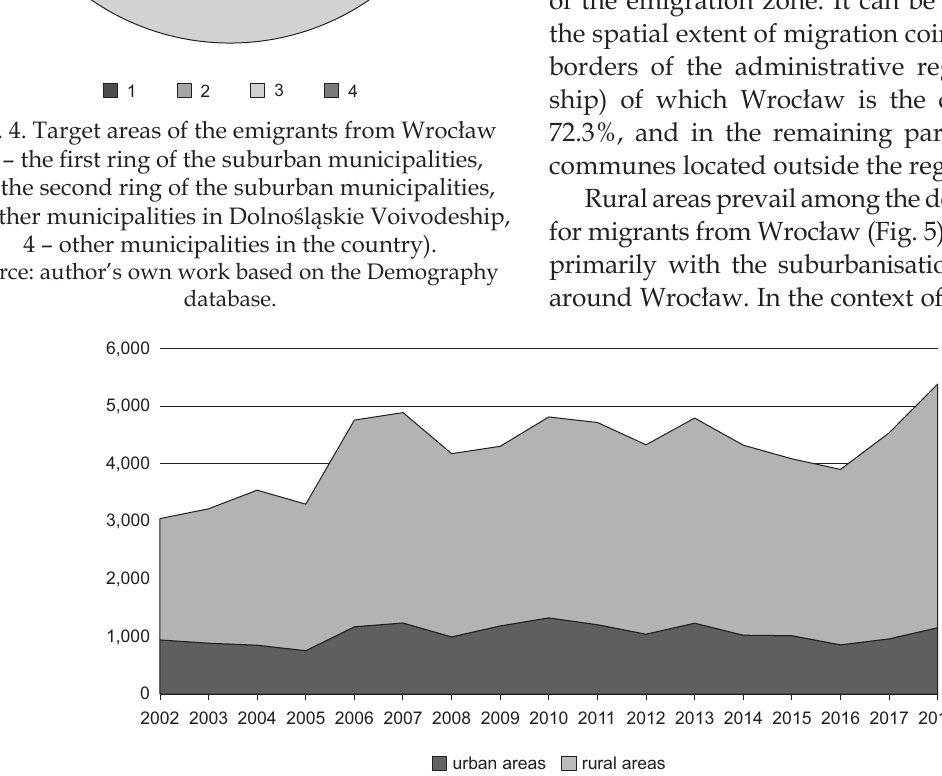
Fig. 5. The size of emigration from Wrocław in years 2002–2018 to urban and rural areas in Dolnośląskie